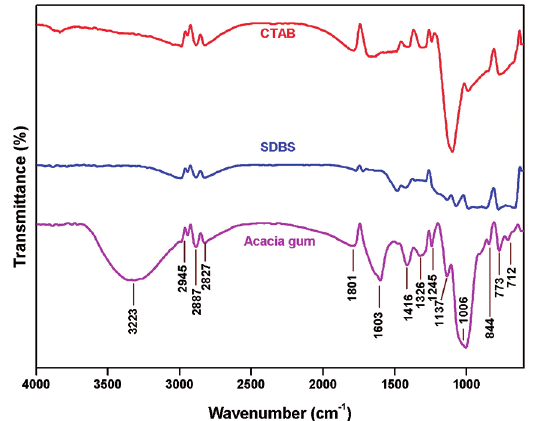
O samples capped with (a) CTAB 2 3